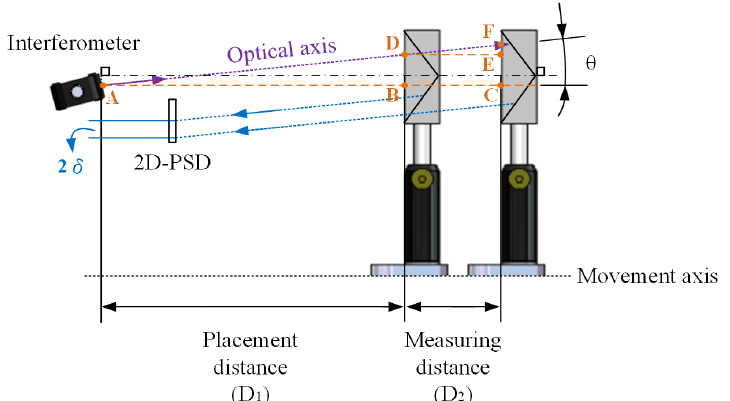
Figure 5. Fine alignment.